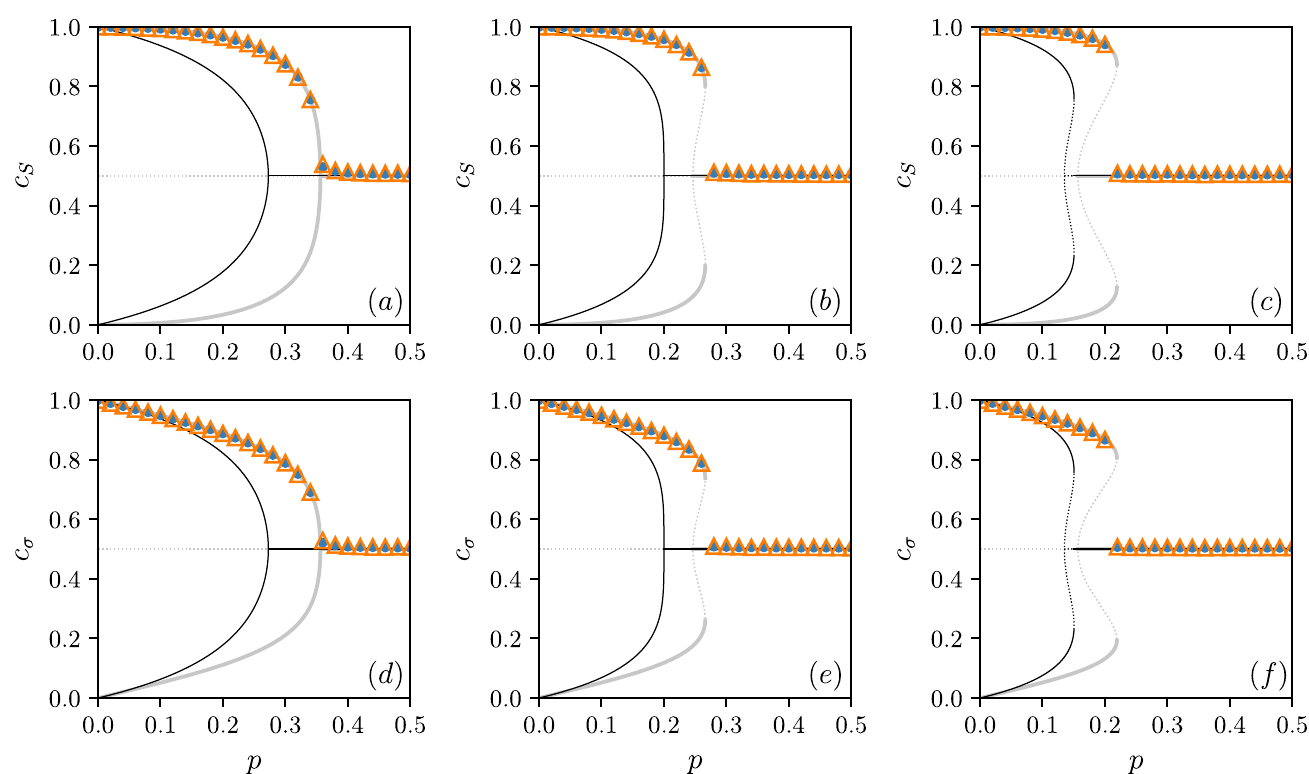
Fig 1. Stationary concentrations of opinions as a function of independence probability p . Concentrations of positive public opinions are presented in upper panels (a)-(c), whereas concentrations of positive private opinions are presented in bottom panels (d)-(f). Different columns correspond to different q -panel sizes: (a) and (d) q = 4, (b) and (e) q = 5, and (c) and (f) q = 6. Analytical results are represented by lines, solid for stable states and dotted for unstable ones: gray lines stand for AT and TA models, whereas black lines, which do not overlap symbols, stand for the original q -voter model with independence [2]. In general, transition points for the original q -voter model are located in the area of smaller values of independence than in the case of AT and TA models. Symbols represent results of Monte Carlo simulations with ordered initial conditions ( S i (0) = σ i (0) = 1 for all agents): 4 for TA (think then act) and • for AT (act then think) models. It is seen that TA and AT models give exactly the same outcomes. Moreover, for q � 5, the metastable region, where both order and disordered phases are stable, and they coexist, shows up. Results from Monte Carlo simulations have been obtained for the system of the size N = 10 5 averaged over 100 samples after 10 5